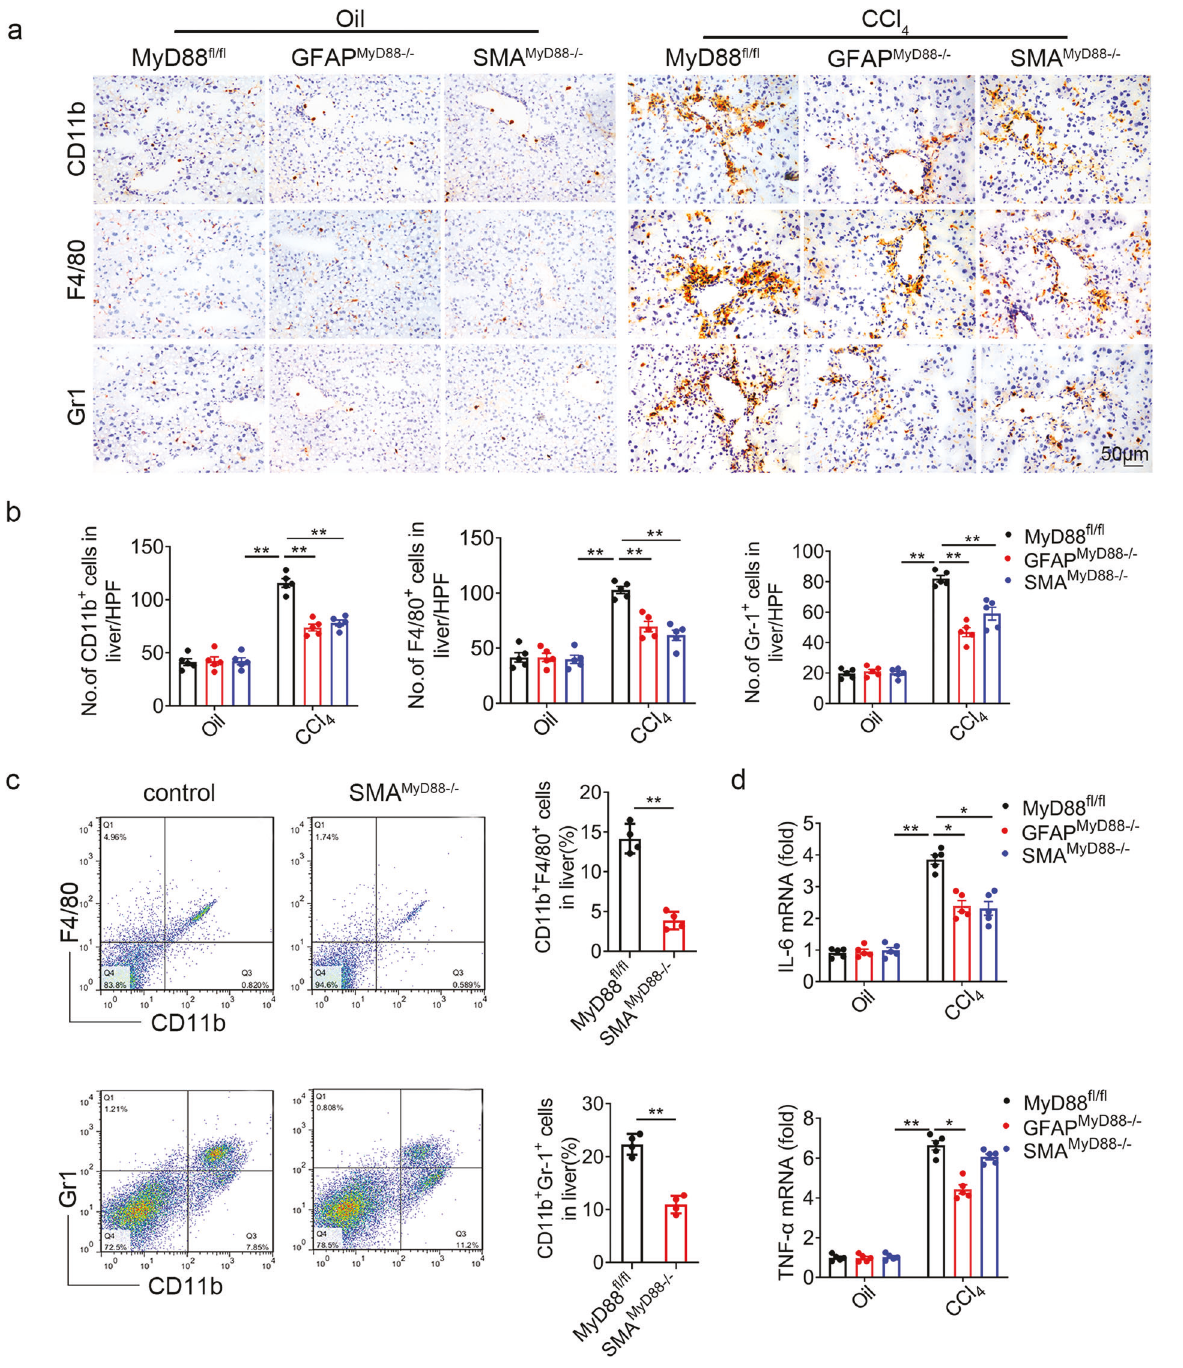
Fig. 3 De fi ciency of MyD88 in HSCs attenuates the CCl 4 -induced liver in fl ammatory response. Groups of MyD88 fl / fl , GFAP MyD88 − / − , SMA MyD88 − / − mice ( n = 5 per group) were subjected to the CCl 4 -induced liver fi brosis. Data were representatives of at least three independent experiments. These charts show the average of the experimental results, with the error bar showing the standard error of mean. a Representative staining of CD11b, F4/80 and Gr-1 in liver tissues (Scale bar, 50 μ m) and ( b ) statistical analysis (magi fi cation, 200×). * p < 0.05, ** p < 0.01. c Isolation of liver lymphocytes from CCl 4 -induced MyD88 fl / fl and SMA MyD88 − / − mice and Flow cytometry analysis of the proportion of CD11b + F4/80 + macrophages and CD11b + Gr-1 + neutrophils in the livers after staining with F4/80, CD11b, and Gr-1 antibodies, ** p < 0.01. d The mRNA levels of IL- 6 and TNF- α in liver tissues were measured using qPCR analysis, * p < 0.05, ** p < (Pam3CSK4) and TLR8 (motolimod) resulted in downregulation of protein expression level in HSCs (Fig. 5f). Toll-like receptors in CXCL10, which is due to inhibition of MyD88 with inhibitor ST2825 HSCs were activated in vitro by different Toll-like receptor (Fig. 5g). TLR8 agonist and LPS have similar effects to promote the activators. Next, we tested whether stimulation of MyD88- expression of CXCL10 in LX-2 depending on the MyD88 pathway. dependent TLRs modulates CXCL10 expression in HSCs. Stimula- In contrast, the agonist for TLR7 (imiquimod) did not affect tion of LX-2 with the bacterial agonists for TLR4 (LPS), TLR1/2